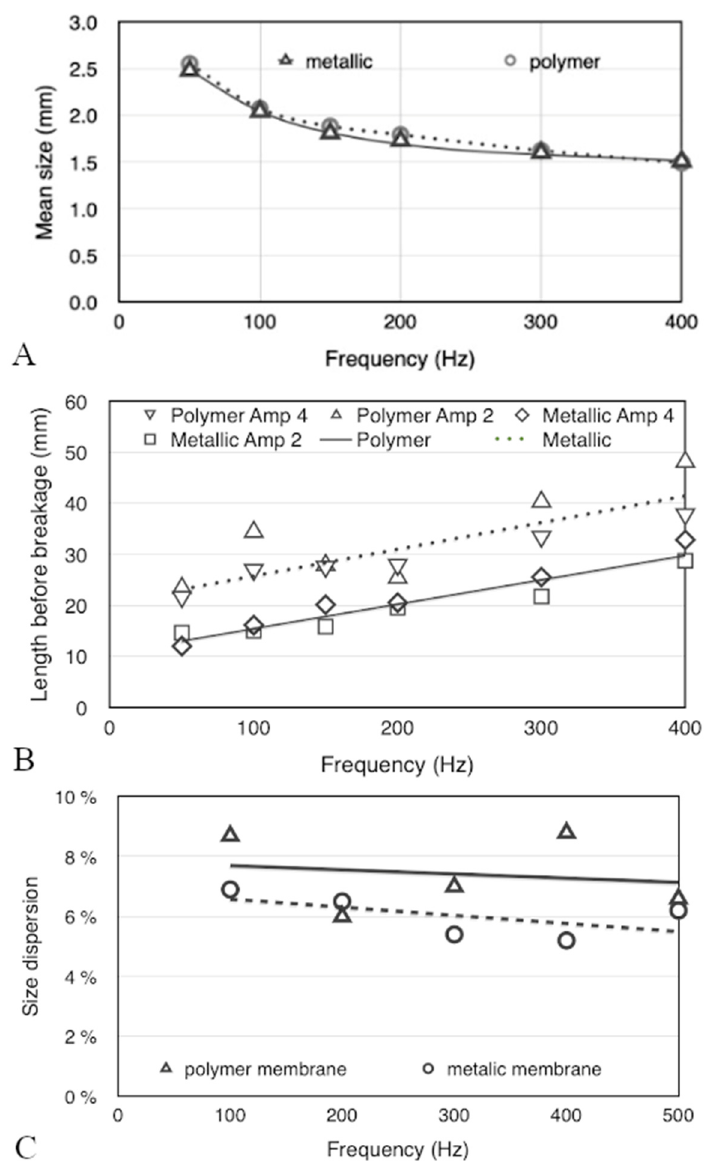
Figure 4. Impact of frequency for metallic and polymer membrane while selecting optimum breakage conditions (see Section 4.1) ( A ) on droplet size (750 µm nozzle, mean error 3%) ( B ) jet length before breakage for two different amplitudes of vibration (mean error 11%). ( C ) Droplet size dispersion (Nozzle 450 µm, amplitude 4, mean error 6%).